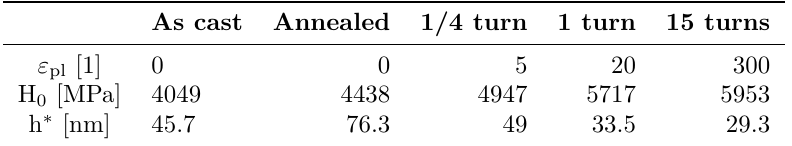
, identified characteristic lengths h ∗ and hardnesses in the pl